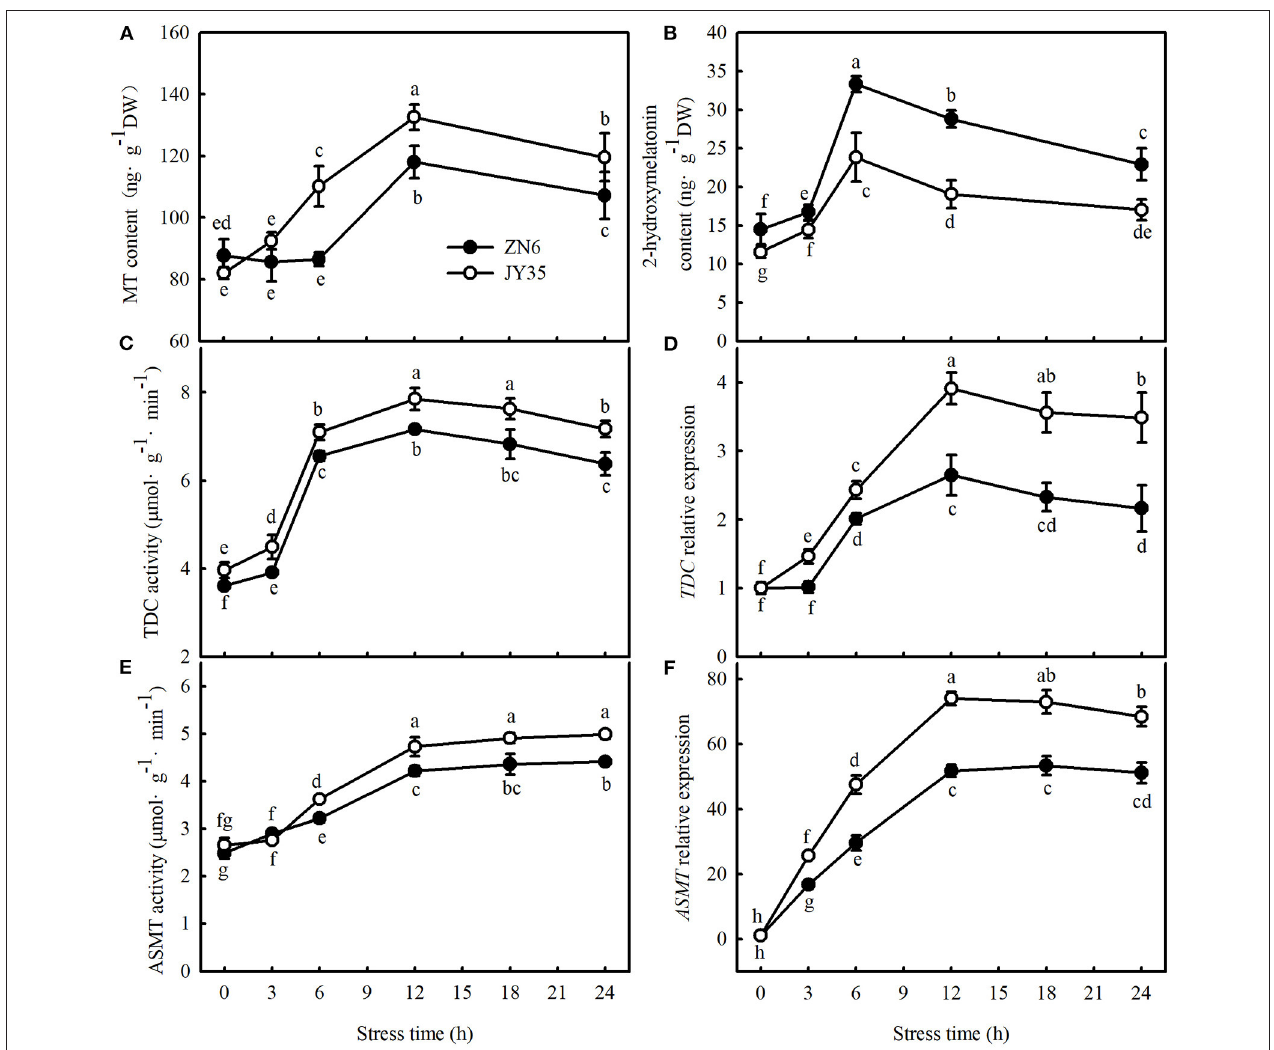
FIGURE 1 | Response of endogenous melatonin (MT) to cold stress in cucumber seedlings. (A) MT content; (B) 2-hydroxymelatonin content; (C) tryptophan decarboxylase (TDC) activity; (D) relative messenger RNA (mRNA) expression of TDC ; (E) acetylserotonin O-methyltransferase (ASMT) activity; and (F) relative mRNA expression of ASMT . Seedlings were treated at 5 ◦ C for 24h and sampled every 3h. Data are the means ± SD ( n = 3). Different letters indicate a significant difference between samples according to Duncan’s new multiple range test ( p <